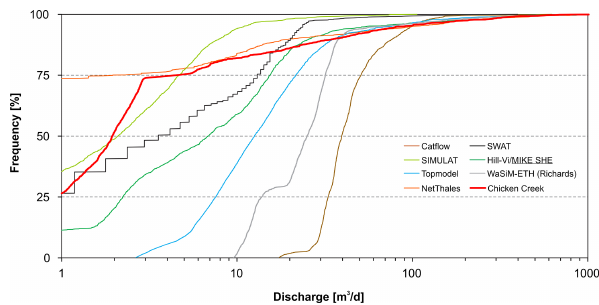
Figure 7. Discharge–frequency relationship of observed and simu- lated daily discharge (third prediction 2005–2008).